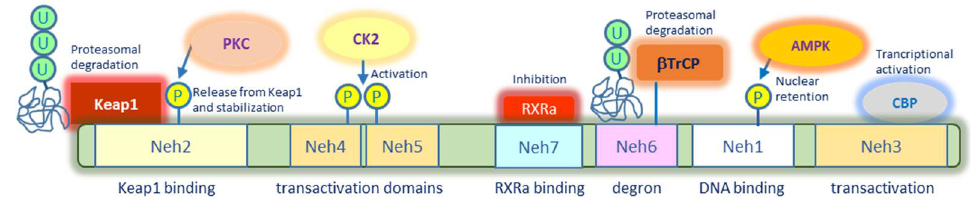
Figure 1. Molecular structure of Nrf2 and post-translational modifications. Seven highly conserved Nrf2-ECH homology (Neh) domains are described together with their main interactors and modifications. Neh1 is the DNA binding domain at specific antioxidant response elements (ARE) and is susceptible to phosphorylation by AMP kinase that causes Nrf2 nuclear retention. Neh2 is the Keap1 binding domain and is subjected to ubiquitination and consequent proteasomal degradation. Neh3 is the transactivation domain and recruits co-activators such as CBP. Neh4 and Neh5 also contribute to transactivation and phosphorylation within these domains promotes Nrf2 transcriptional activity. Neh6 is an alternative degradation domain that recognizes the ubiquitin E3 ligase β-TrCp. The Neh7 domain binds to retinoid X receptor α (RXRα) that suppresses Nrf2 transcriptional activity.